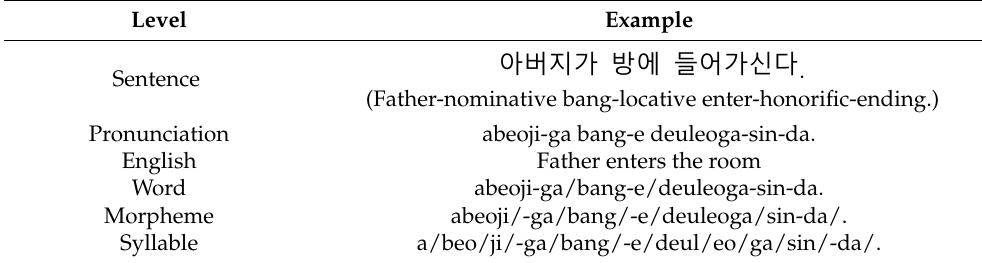
Table 1. Examples of Korean text levels.